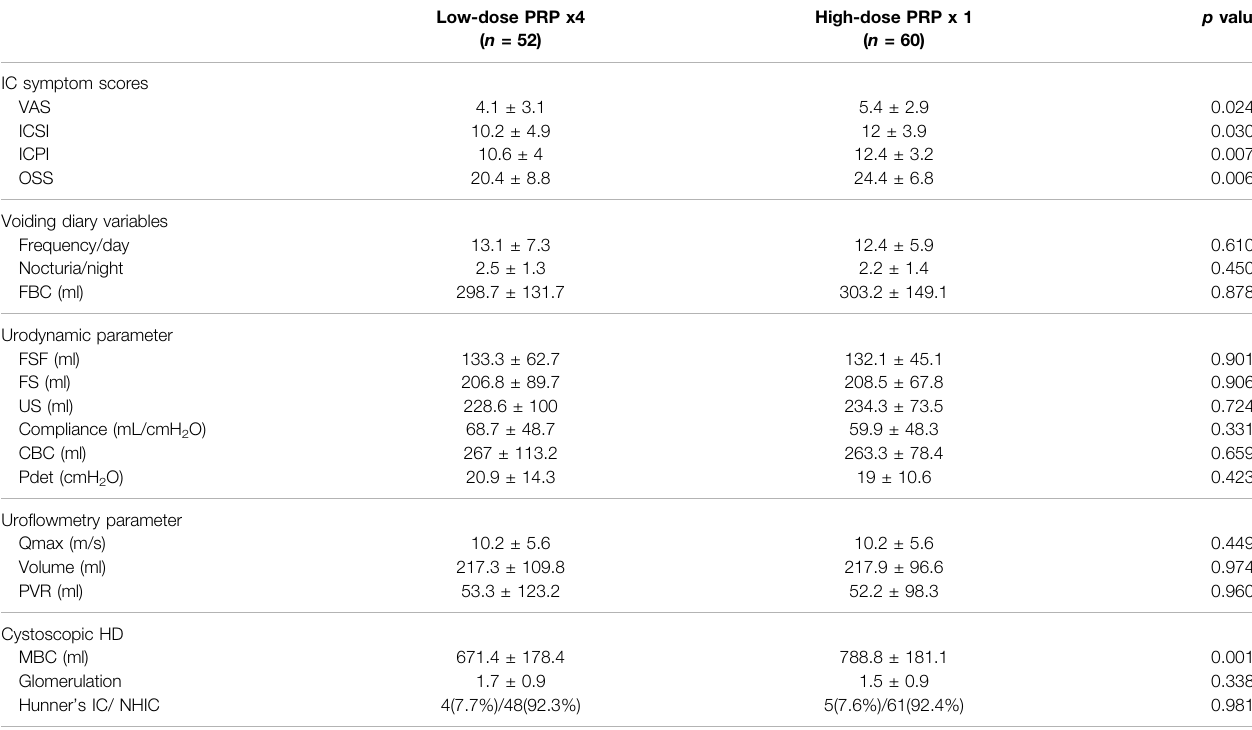
FSF, fi rstsensationof fi lling;FS,fullnesssensationofbladder;US,urgesensation;CBC,cystometricbladdercapacity;Pdet,detrusorpressure;Qmax,maximum fl owrate;MBC,maximal bladder capacity; NHIC, non-Hunner ’ s IC; PRP, platelet-rich plasma.